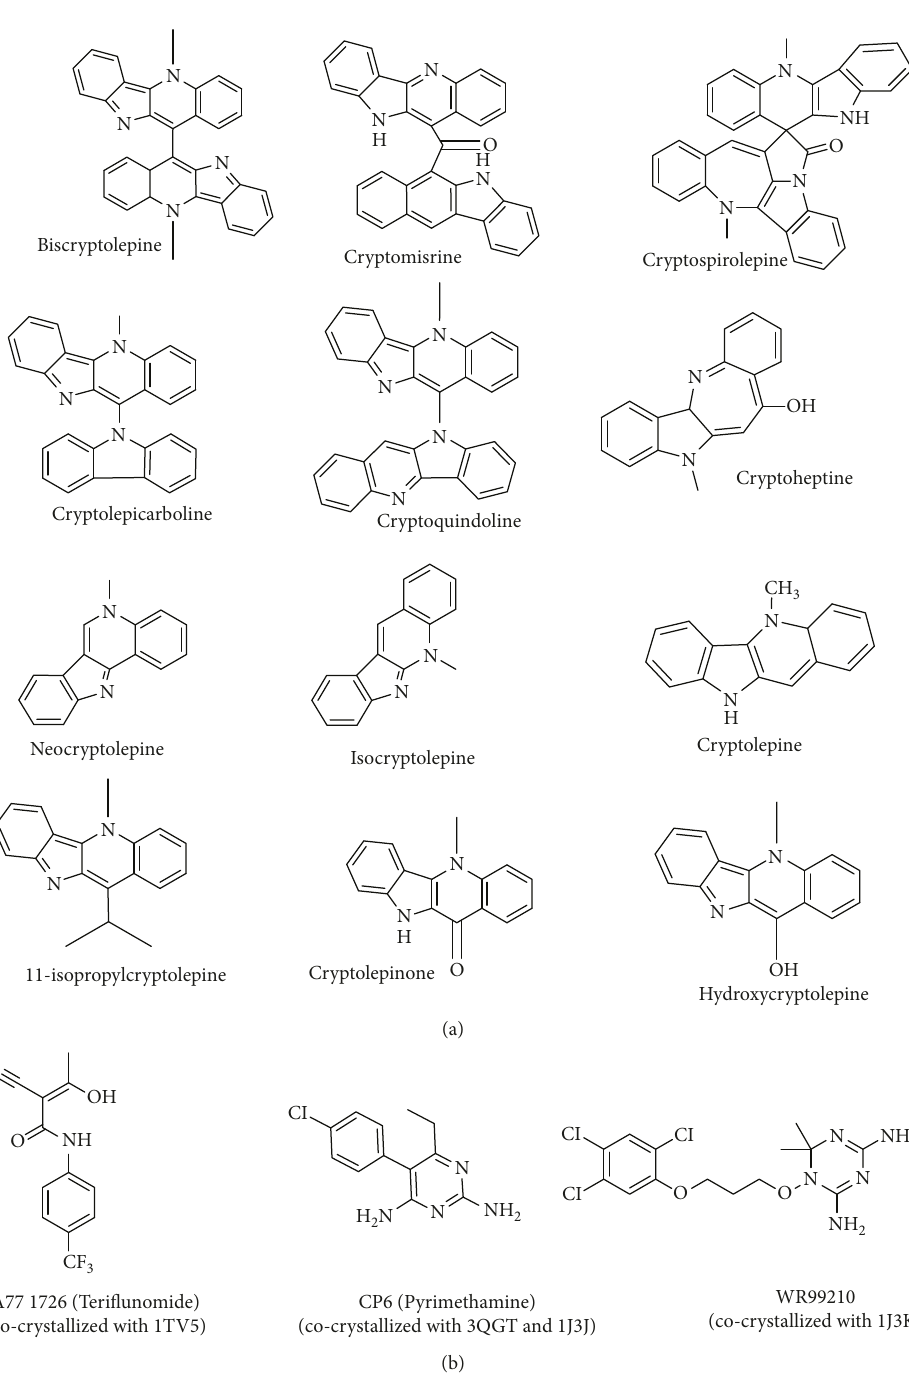
Figure 2: Structures of (a) Cryptolepis sanguinolenta alkaloids and (b) other ligands that were cocrystallized with proteins used in this conformations of the redocked ligands and an initial blind was made by redocking ligands (inhibitors) from the pro- docking influenced the centers and sizes of grid box coor- tein-ligand complexes into their binding sites. In order to dinates (Table 1) of the respective binding pockets chosen. verify docked poses as representative of correctly bound The poses of the ligands for each target were ranked ligand conformations, overlays were created with experi- according to their binding energies by AutoDock Vina in mentally determined binding modes and root mean square UCSF Chimera. Ligands with very low binding energies and deviations (RMSD) estimated in PyMOL. The bound